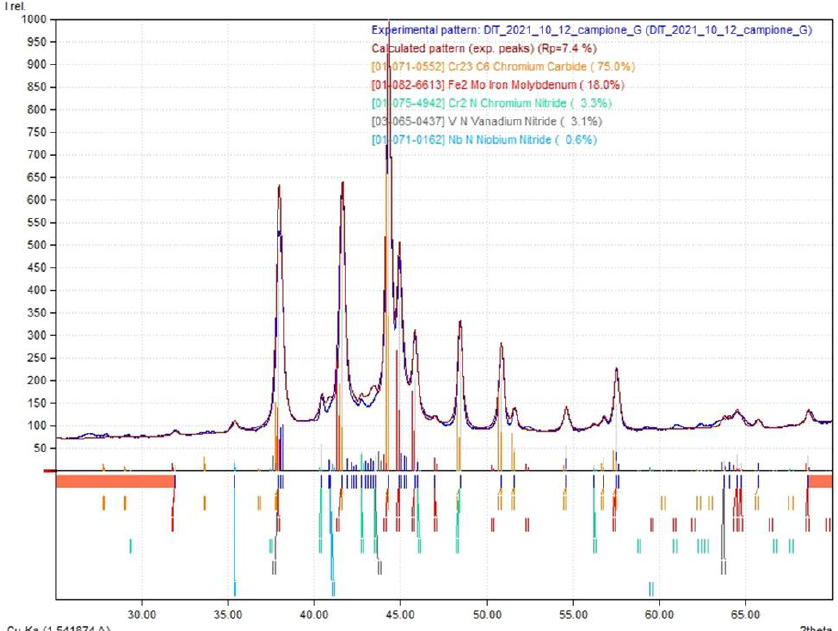
Figure 20. Failed crept cross-weld specimen 92-HAZ-6-5 650 °C 78 MPa 4616 h (sample G), XRD analysis.